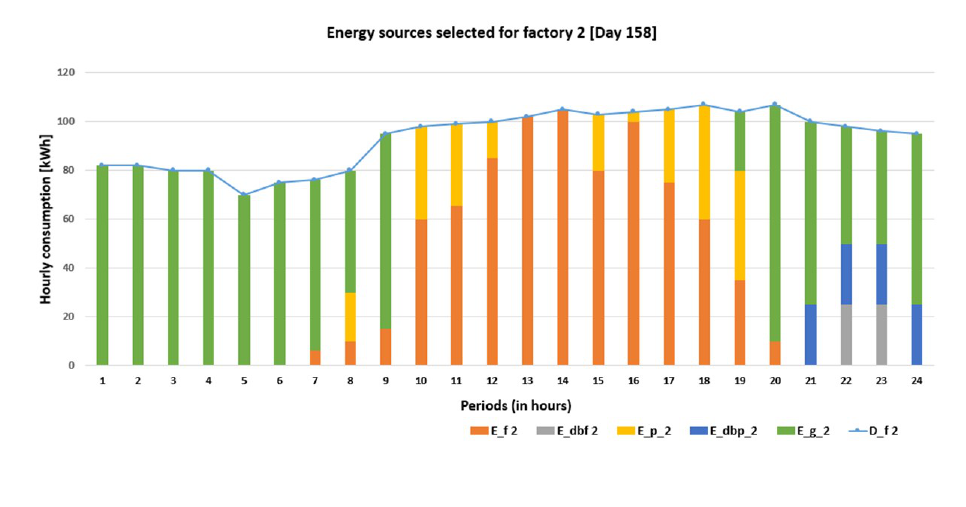
Figure 6. The selected energy sources for factory 2 during day